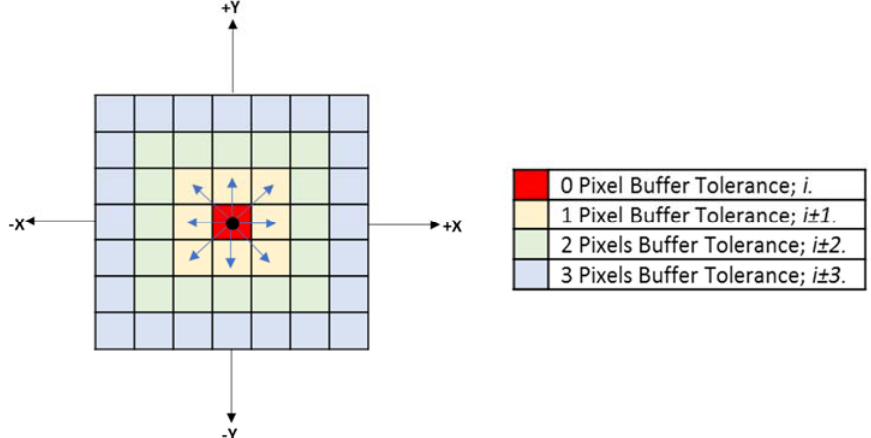
Figure 4. Concept of the pixel buffer tolerance values (PBTVs).